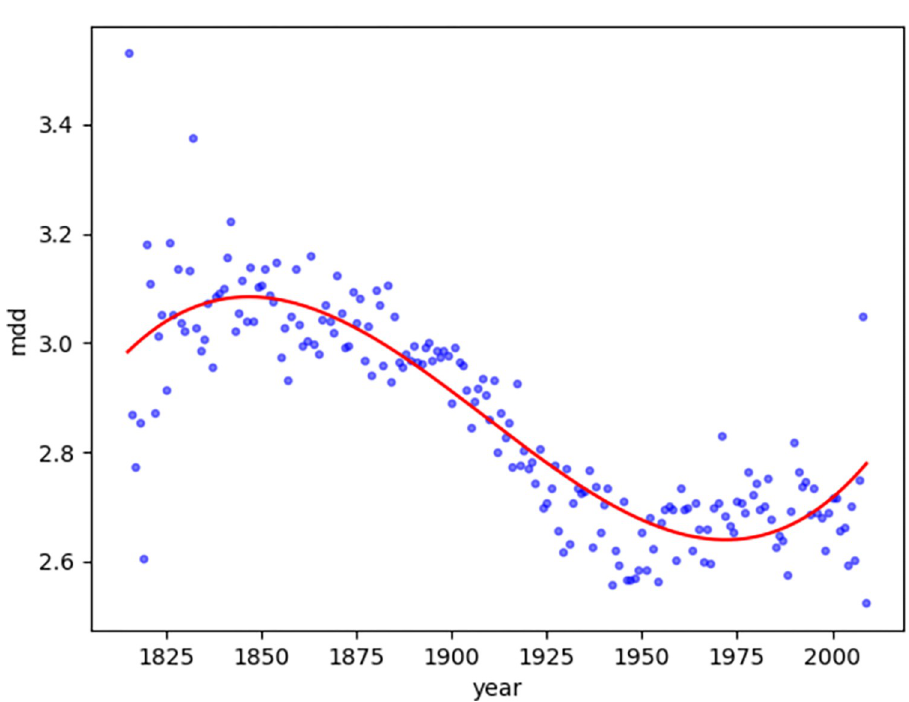
Fig 4. Diachronic non-linear distribution of MDD for magazine